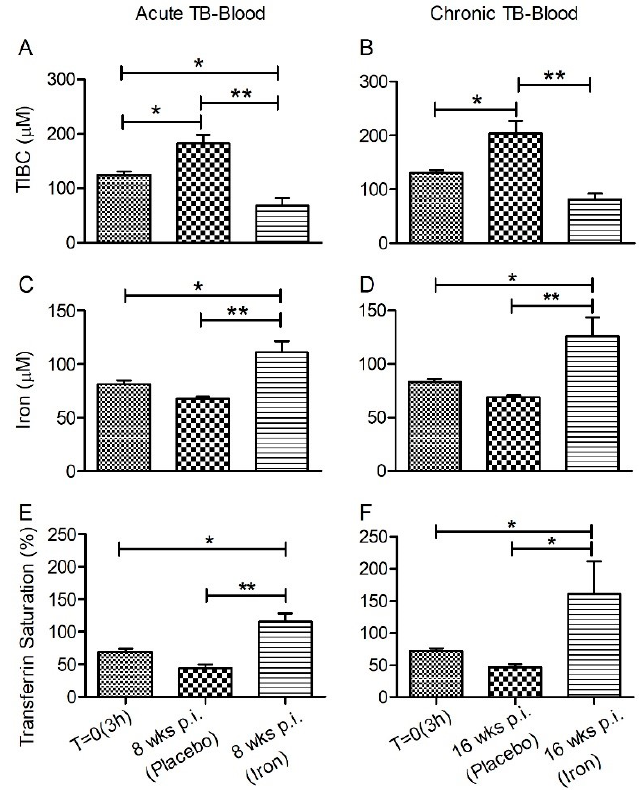
Figure 1. Effect of Fe-supplementation on plasma iron parameters of rabbits at 8 weeks ( A , C , E ) or 16 weeks ( B , D , F ) post-Mtb infection. Total iron binding capacity (TIBC) (top), total iron (middle), and percent transferrin saturation (bottom) were determined in plasma samples of Mtb-infected and placebo- or Fe-treated rabbits at the conclusion of treatment (i.e., 8 weeks or 16 weeks post-infection). Data was analyzed by one-way Anova with Tukey’s multiple comparison test. Values plotted are mean +/– sd with n = 4 per group per time point. * p < 0.05; ** p < 0.01.